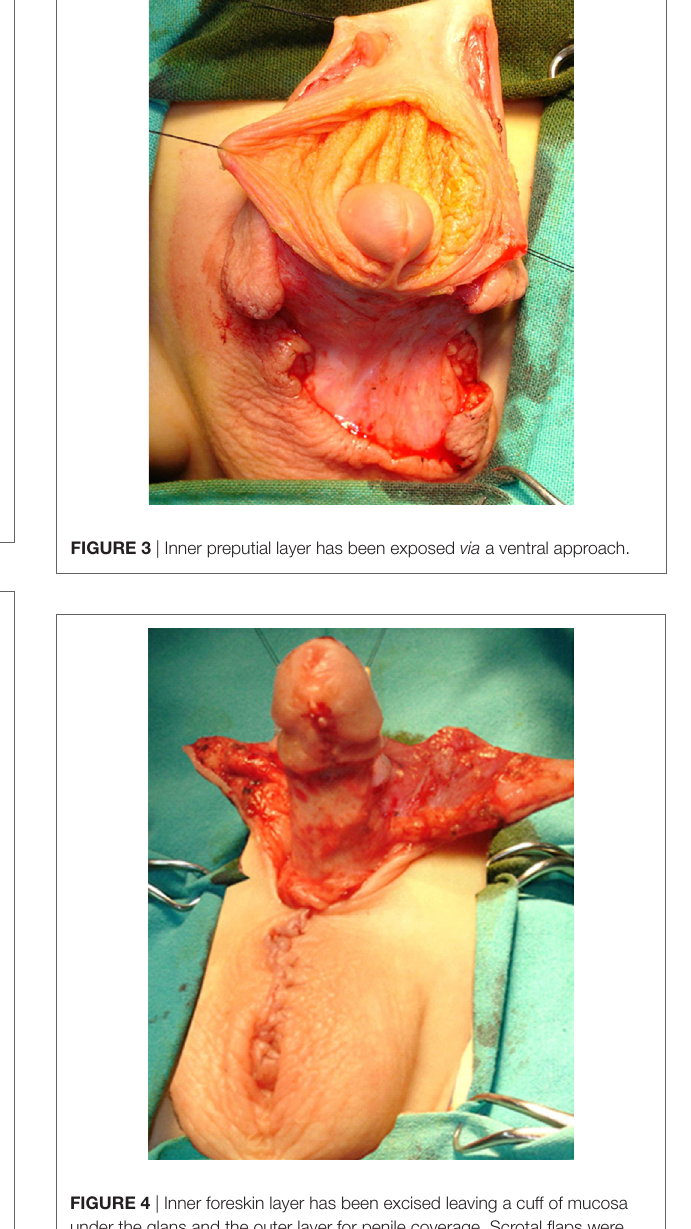
FigUre 4 | Inner foreskin layer has been excised leaving a cuff of mucosa under the glans and the outer layer for penile coverage. Scrotal flaps were dissected and sutured together in the midline.